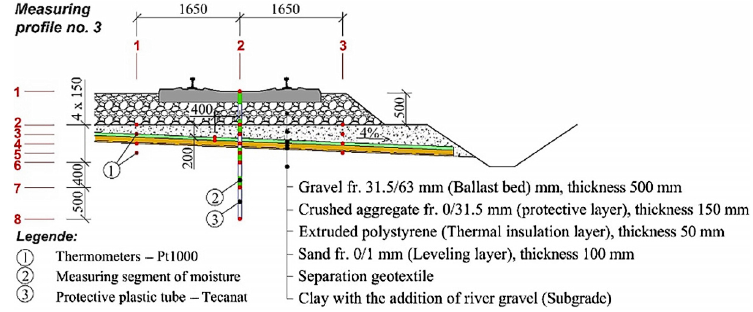
Figure 2. Experimental stand DRETM – measuring profile no. 3 (Pieš,